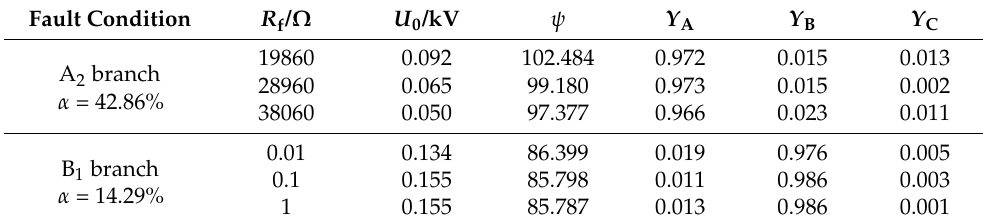
Table 3. The result of phase